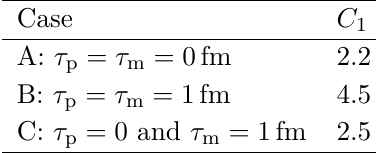
Table 2 . Values of C 1 obtained by fitting ALICE R AA [58] data with p T > 6 GeV for the 20 - 30% √ centrality class in s NN = 2 . 76 TeV Pb-Pb collisions for the three different cases analyzed in this paper (see figure